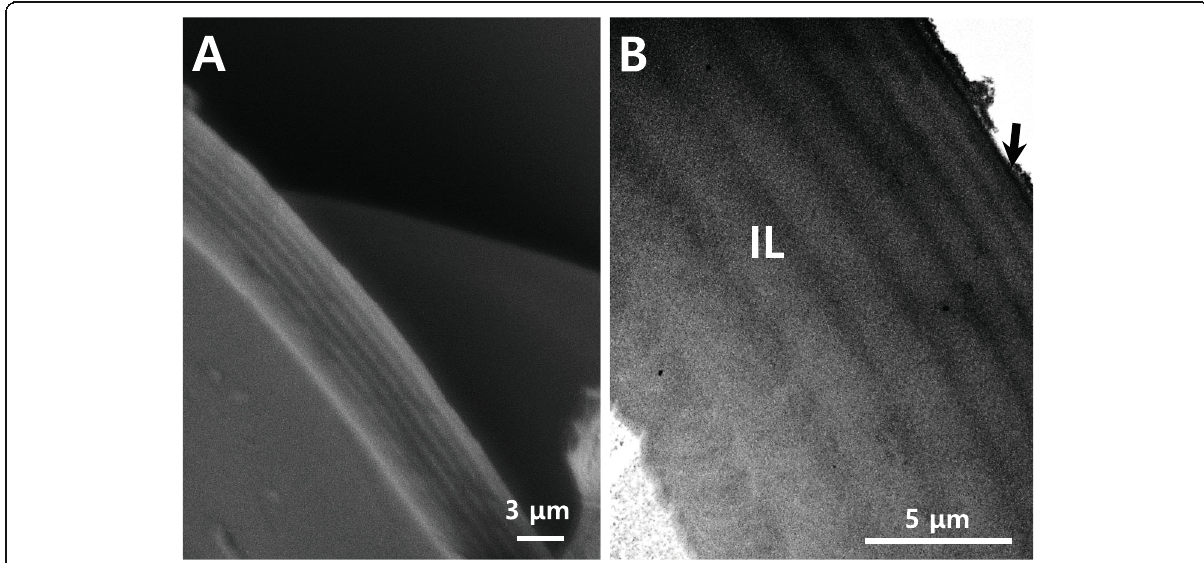
Fig. 5 The electron micrographs of the fertilized egg envelopes section. The fertilized egg envelope was a multi-layer lamellar structure in SEM image ( a ). The egg envelope consisted of two layers, an inner lamella layer (IL) and an outer layer with high electron-density (arrow). And the inner layer was 8 layers on TEM image ( b